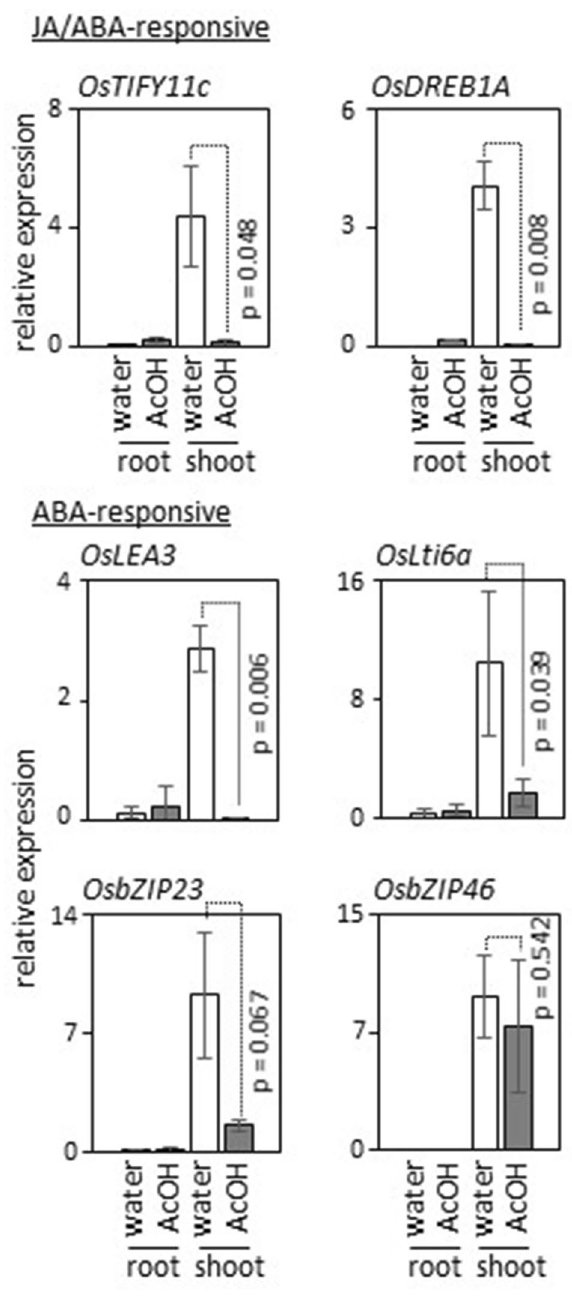
Figure 5. Attenuated responses of JA and ABA signaling under subsequent drought conditions. Expression levels of JA/ABA- and ABA-responsive genes in root and shoot at 1 day of drought treatment following water (white bars) or acetic acid (grey bars) treatment were analyzed by quantitative RT-PCR. Relative expression levels were calculated using 25S rRNA as a control. OsTIFY11c and OsDREB1A are JA- and ABA-responsive genes. OsLEA3 , OsLti6a , OsbZIP23 , and OsbZIP46 are ABA-responsive genes. Primers used are listed in Supplementary Table S17 online. Statistical significance was examined by Student’s t-test. n =